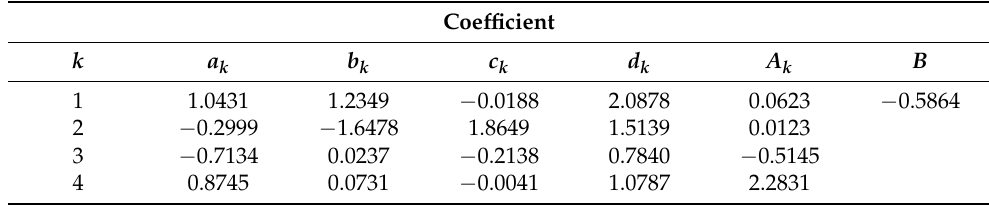
Table 4. Coefficient of Equation (8) for ANN2